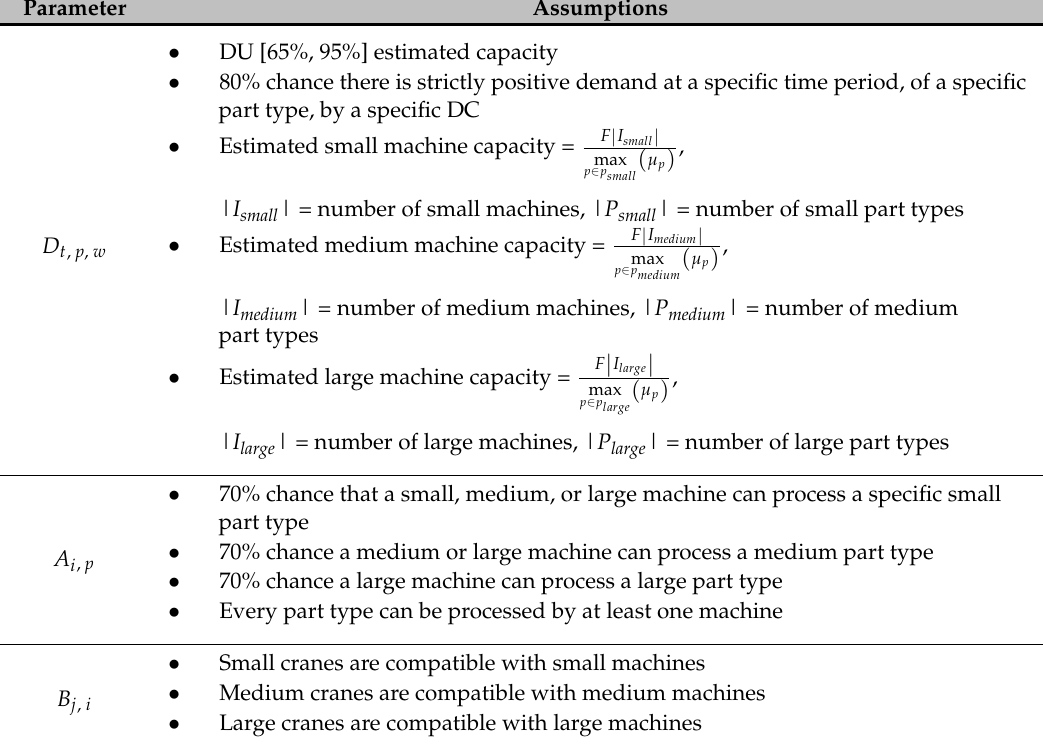
Table 5. Details for generating experimental parameters D , A , B , and C .